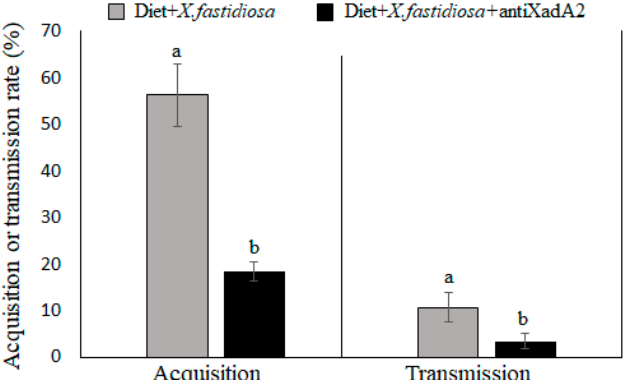
Figure 3. Effect of antibody against XadA2 adhesin (anti-XadA2) on the acquisition and transmission efficiencies of Xylella fastidiosa by Macugonalia leucomelas from an artificial diet in a membrane feeding system. Efficiency rates are expressed by the mean percentage of insects that acquired (±SEM; n = 60) or transmitted (±SEM; n = 30) the bacterium. Means with different letters for a same parameter (acquisition or transmission) differ statistically by Fisher’s exact test ( p < 0.05).